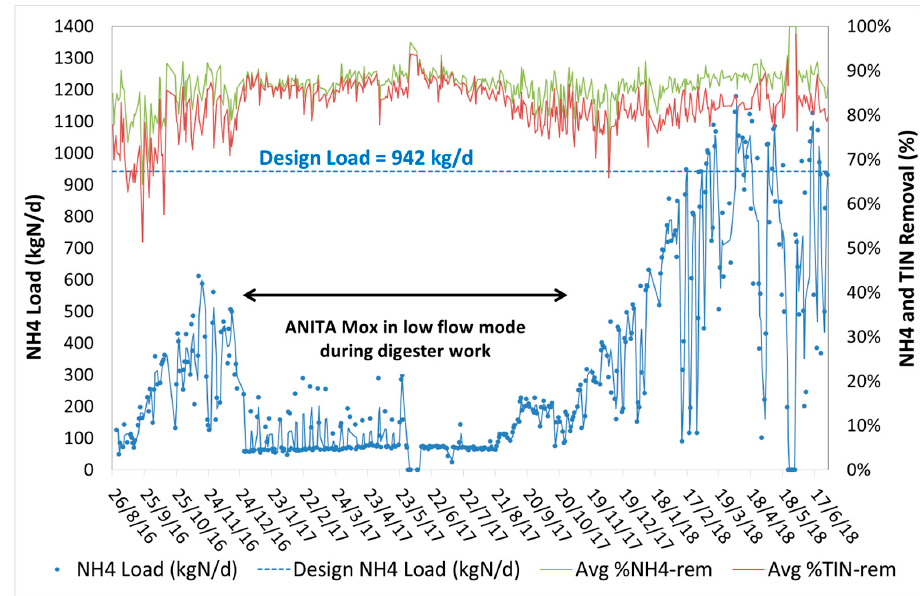
Figure 4. NH 4 load, NH 4 , and TIN removal efficiency.